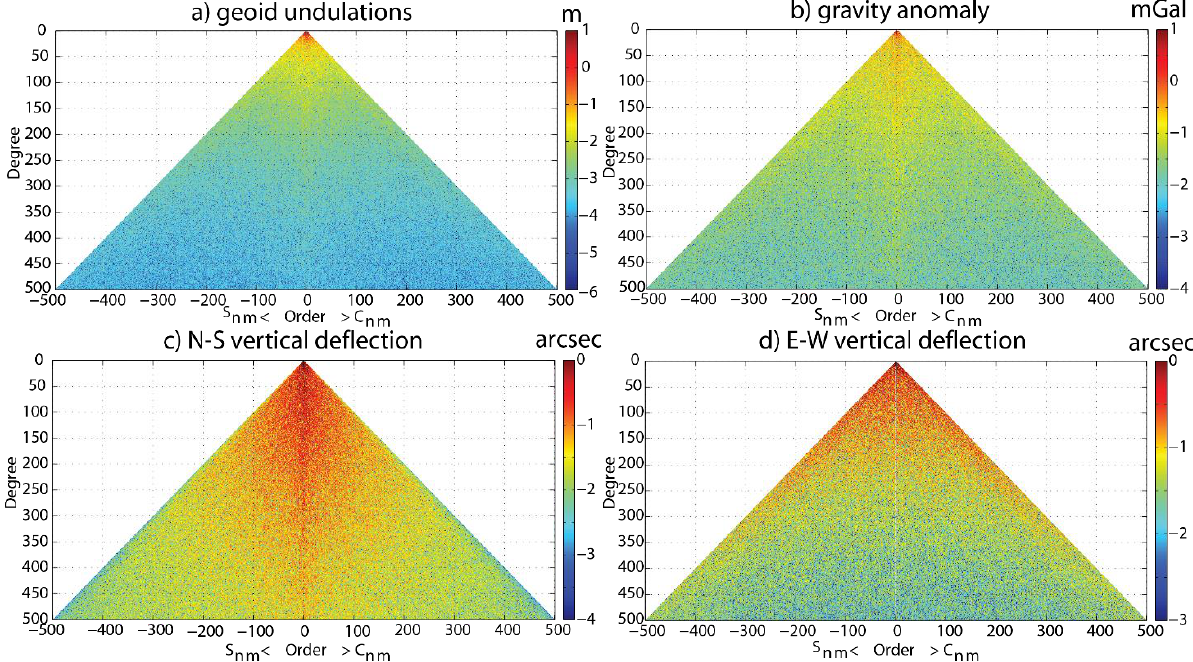
Figure 3. The results of the sensitivity analysis using EIGEN-6C model to degree and order 500 for a) geoid undulations in m, b) gravity anomaly in mGal, c) north-south vertical deflection in arcsec and d) east-west vertical deflection in arcsec. The quantities